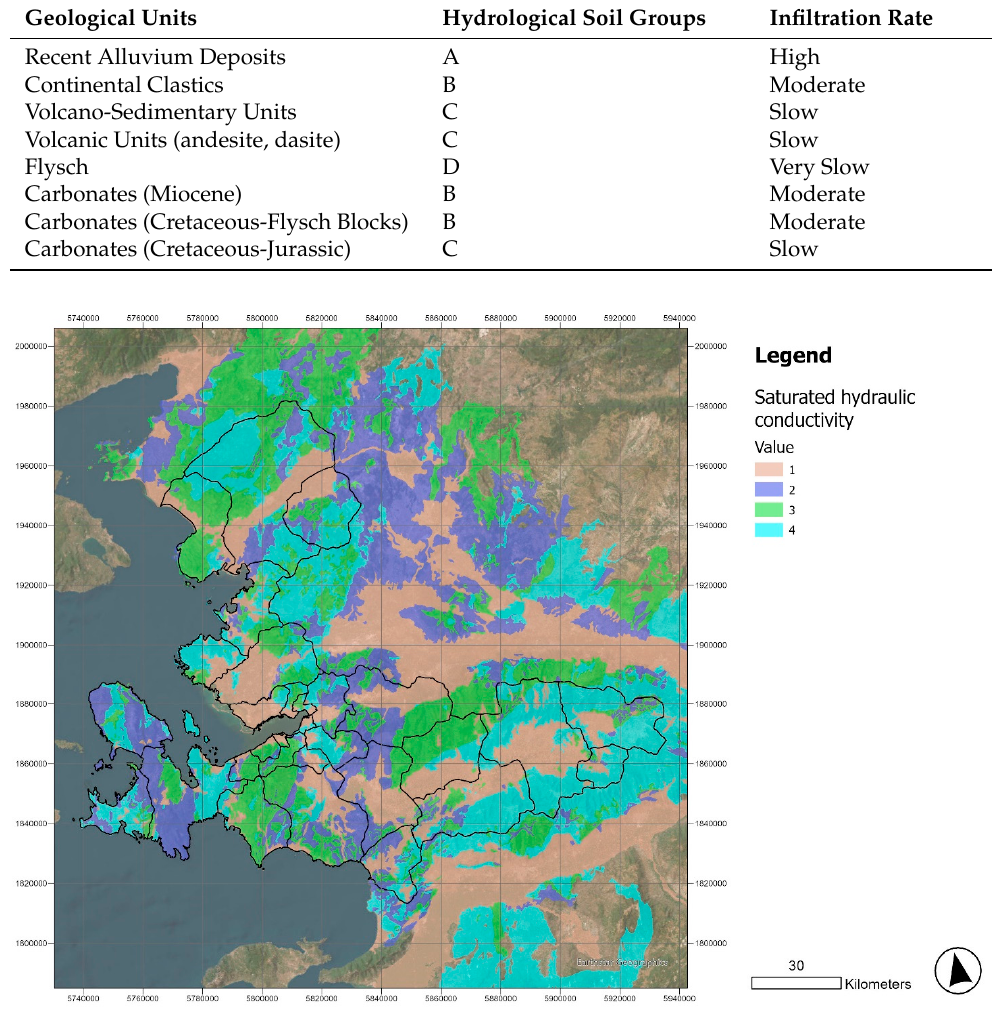
[40;10] m/s [10;1] m/s <1 m/s